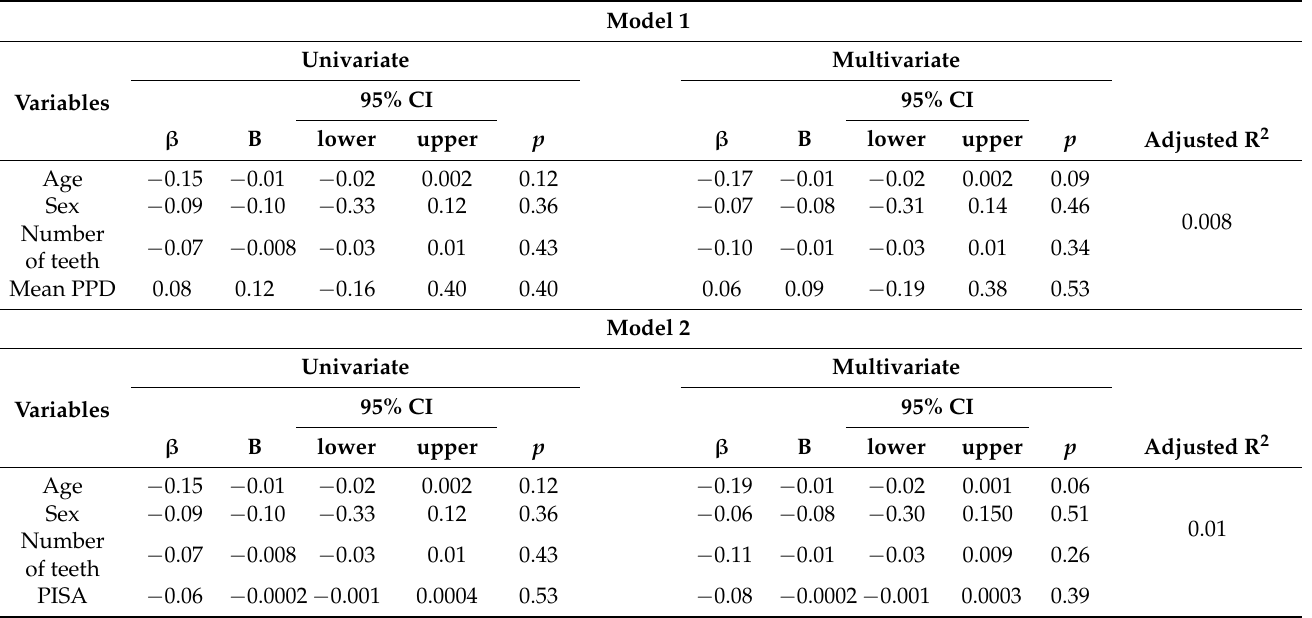
Table 3. Multivariate analysis of the association between PPD or PISA and HbA1c in patients with severe diabetes mellitus. (N =